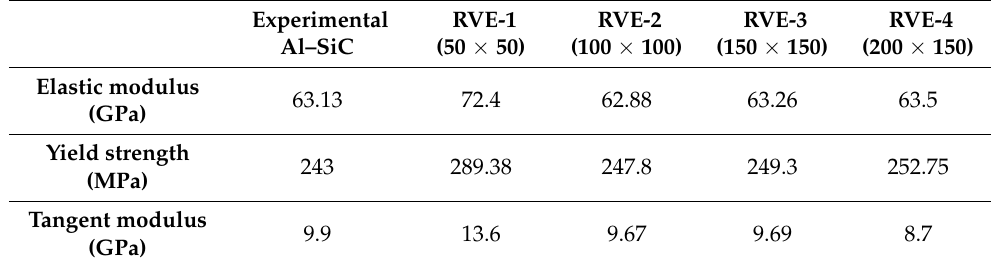
Table 2. The experimentation results and computational results of the RVE